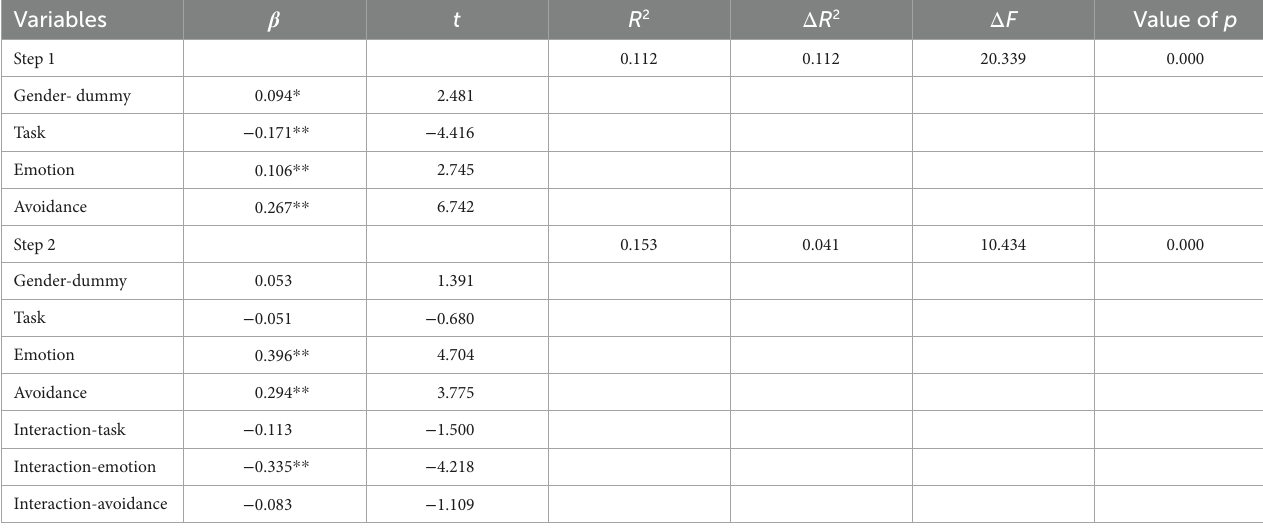
TABLE 3 The moderating effect of gender on the relationship between coping and distress.